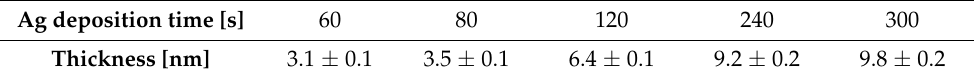
Table 1. Dependence of the thickness of a silver layer [nm] deposited on the PTFE and PFA surface. Ag deposition time [s]